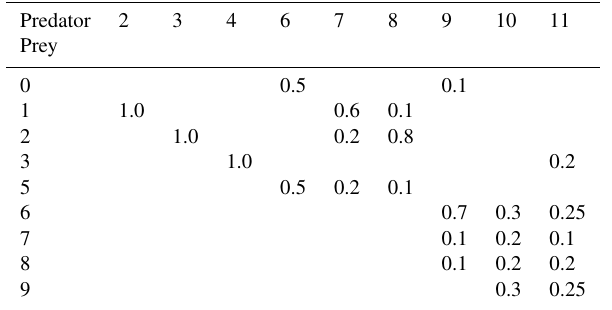
Table 2. Preference factor of predator of type i for prey of type j . Predator